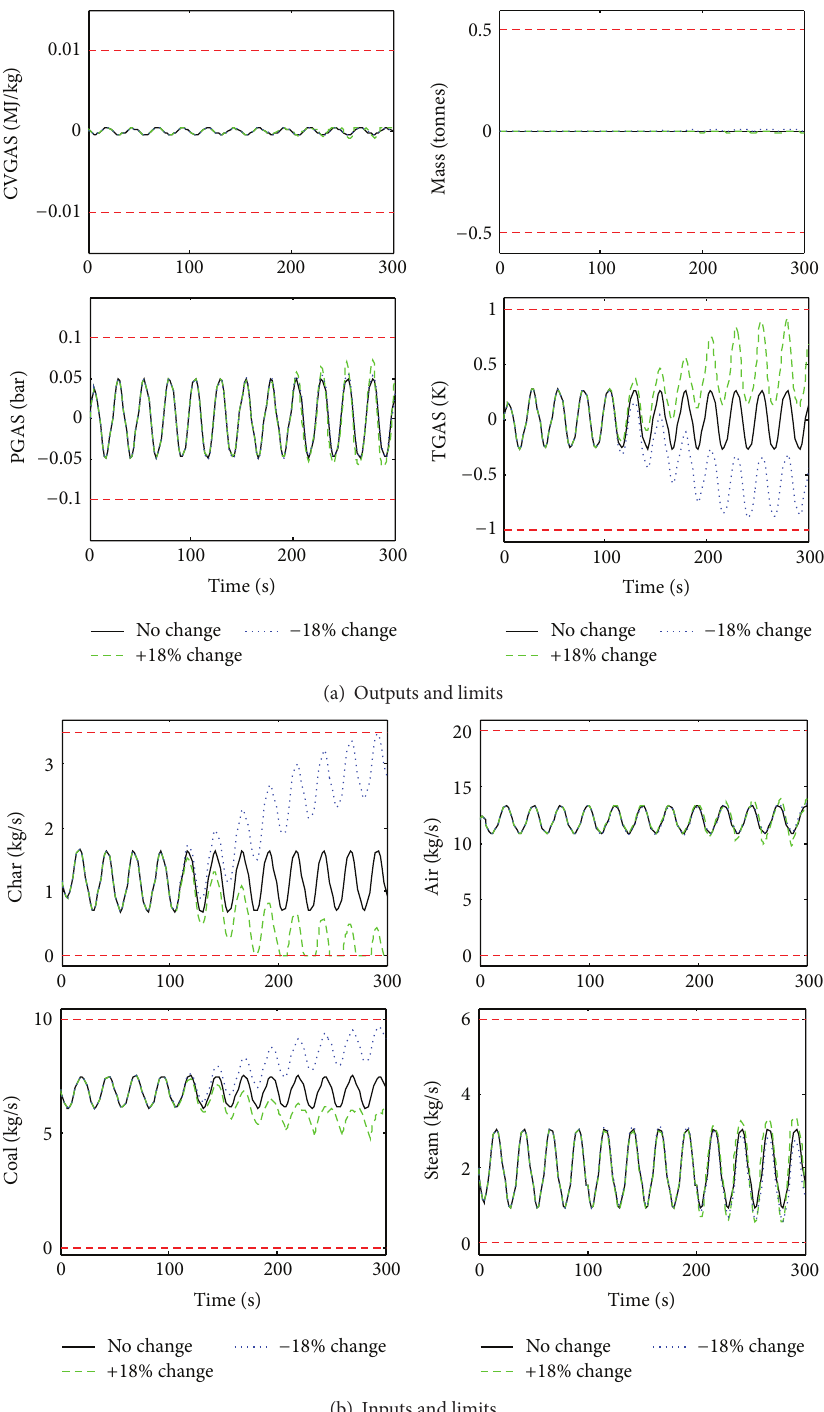
Figure 7: Response to sinusoidal disturbance at 50%